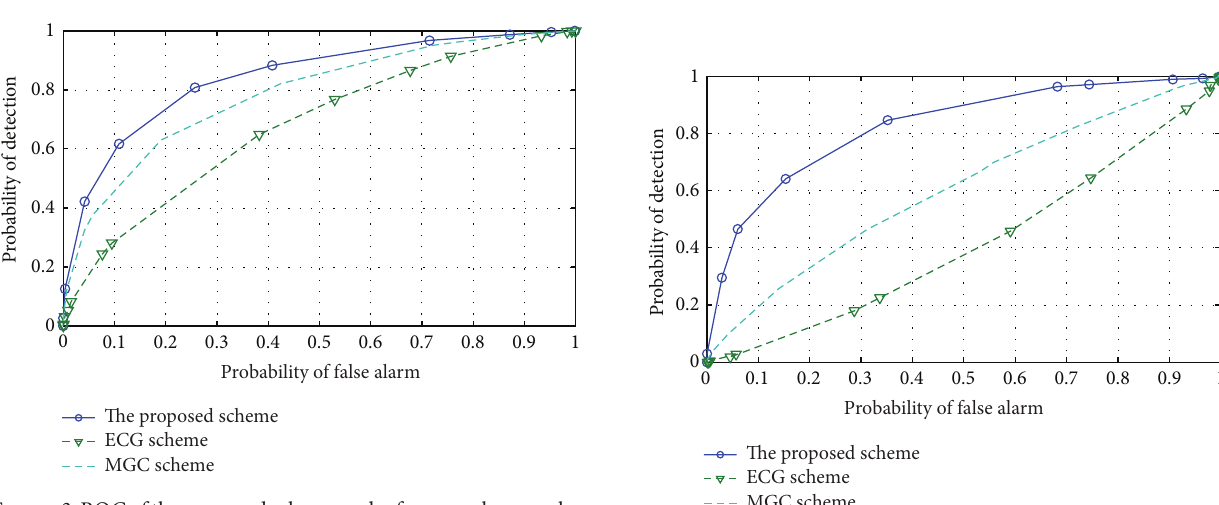
Figure3:ROCoftheproposedschemeandreferenceschemeswhen 4 always No malicious CUs are considered.